Question: Write the caption for this figure.
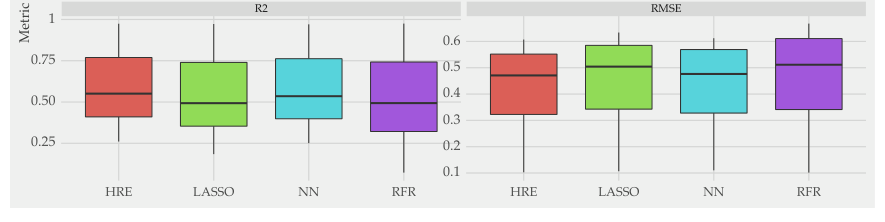
Answer: Distribution of forecasting performance across the forecasting horizon for each regres- sion approach by different metrics.